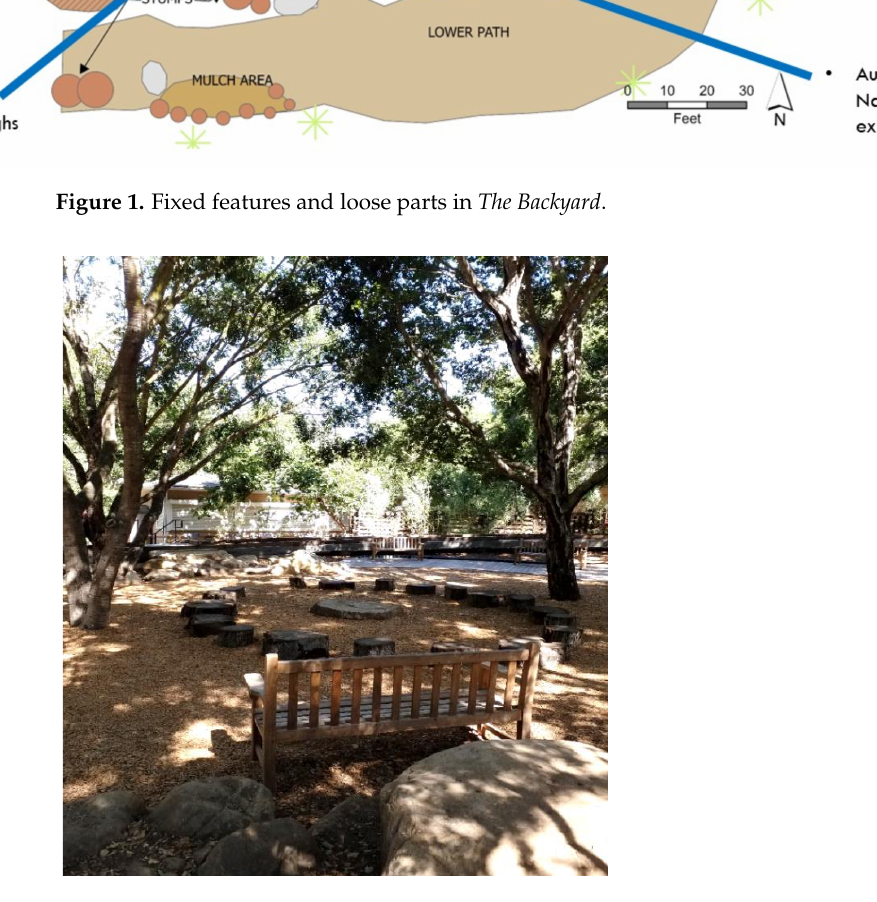
Figure 3. Mud kitchen and treehouse areas.